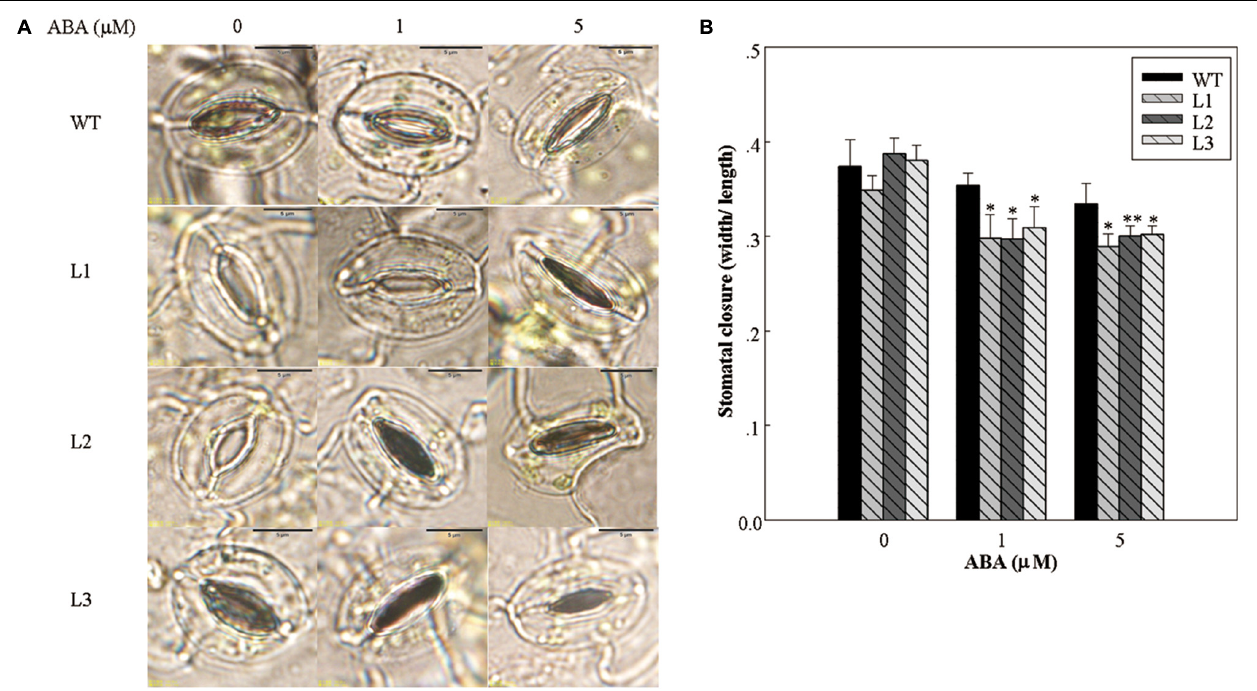
FIGURE 5 | Stomatal closure in response to abscisic acid (ABA) treatment in WT and VlWRKY3 transgenic Arabidopsis thaliana plants. (A) Comparison of stomatal apertures in response to different concentrations of exogenous ABA in WT and transgenic plants. (B) Stomatal aperture width to length ratios following treatment with different concentrations of exogenous ABA. Data values represent means ± SD from three independent experiments. Asterisks indicate statistical significance ( ∗ 0.01 < P < 0.05, ∗∗ P < 0.01, Student’s t -test) of differences between transgenic lines and WT